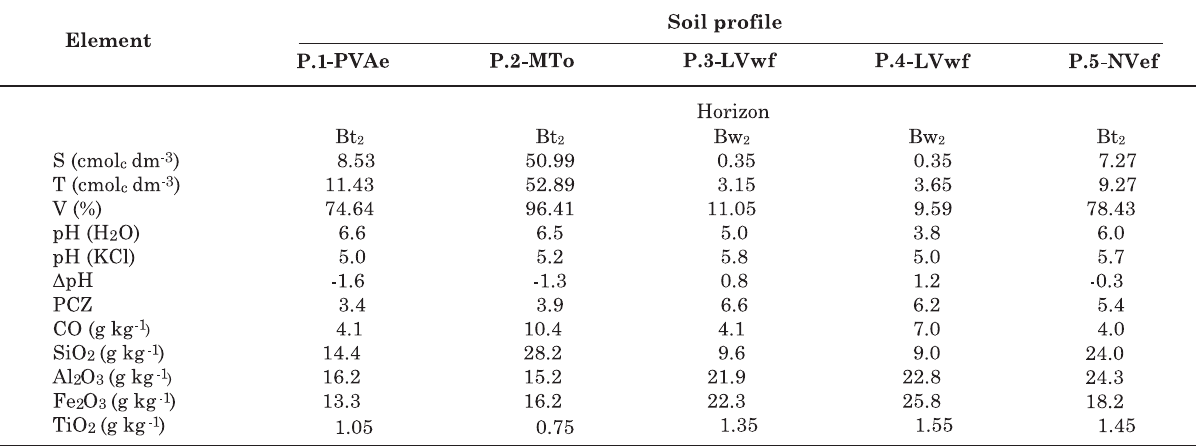
Table 1. Mean values of chemical and mineralogical properties of the soil samples in horizon